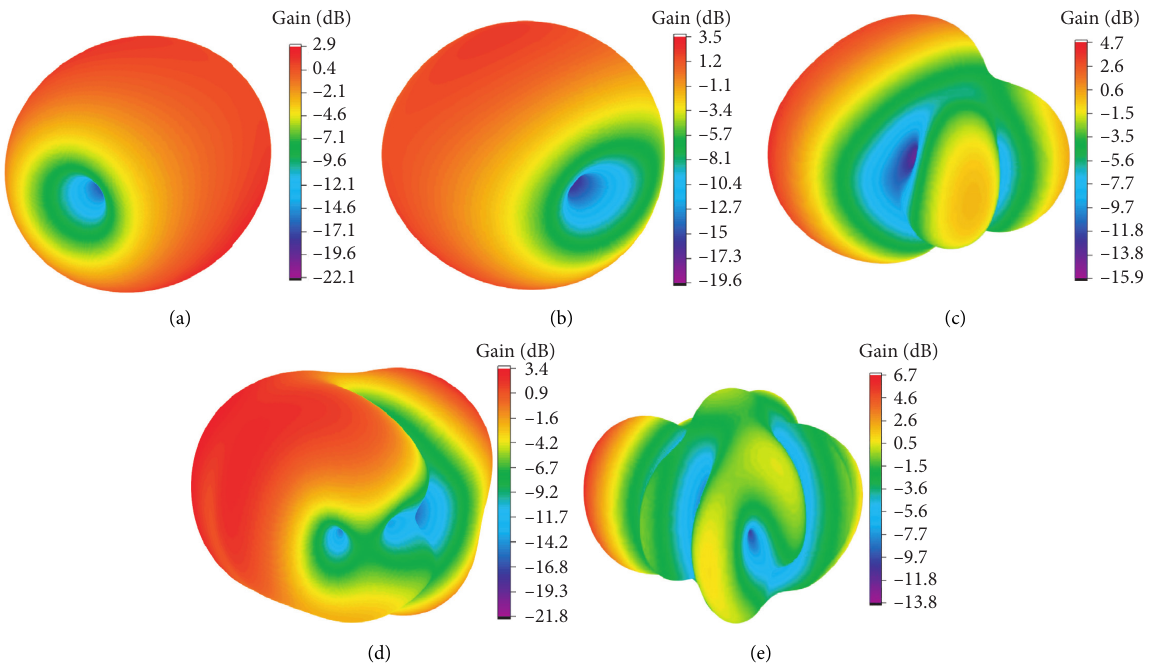
Figure 12: The simulated 3D gain of the proposed VBi-UWBA at (a) 4.5GHz, (b) 5.5 GHz, (c) 7.5GHz, (d) 10.5GHz, and (e) 13.5GHz.